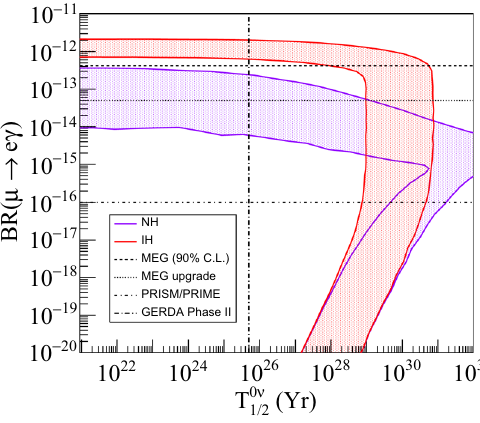
Fig. 12 Correlation plot between LFV processes μ → e γ and